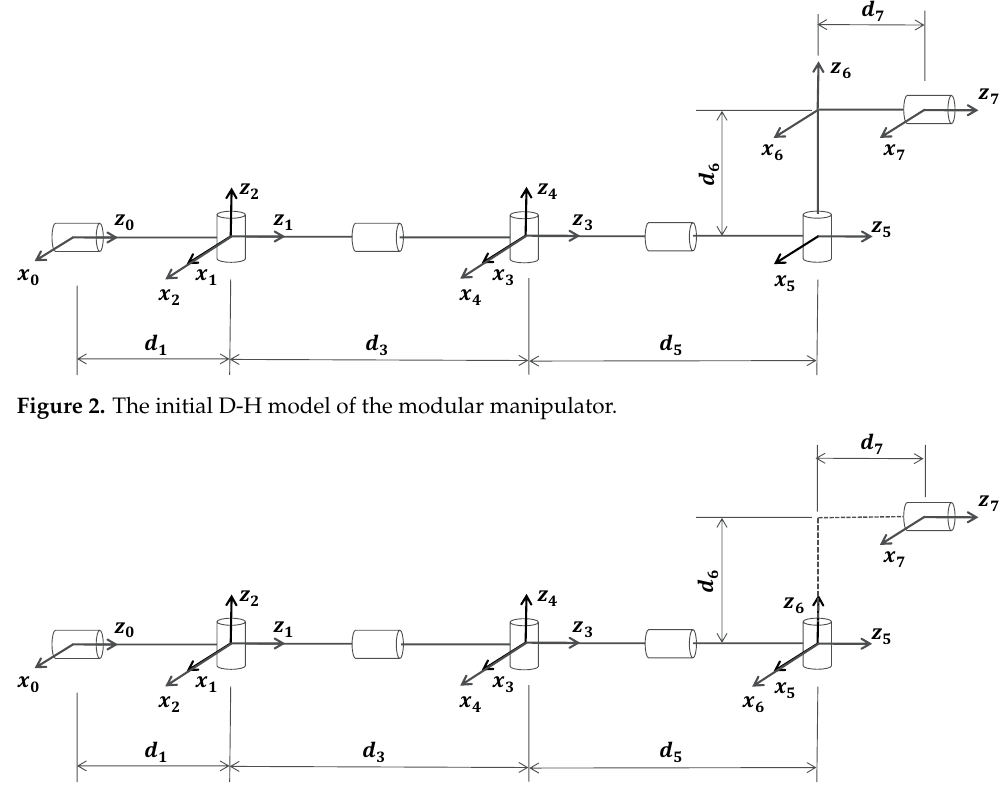
Figure 1. The modular manipulator studied in this paper.